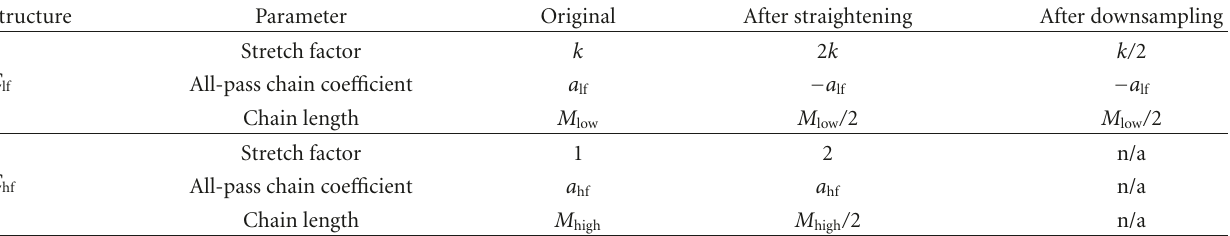
Table 1: Modifications required to the parameter values of the all-pass cascades in structures C lf and C hf , after chirp straightening and downsampling.